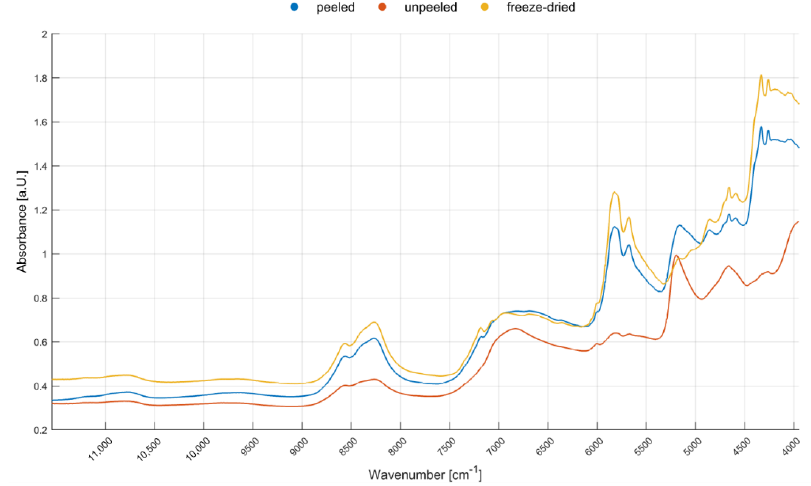
Figure 3. Mean spectra of an uncrushed peeled walnut, an uncrushed unpeeled walnut, and of a ground and freeze-dried walnut sample in a wavenumber range 11,550 – 3950 cm – 1